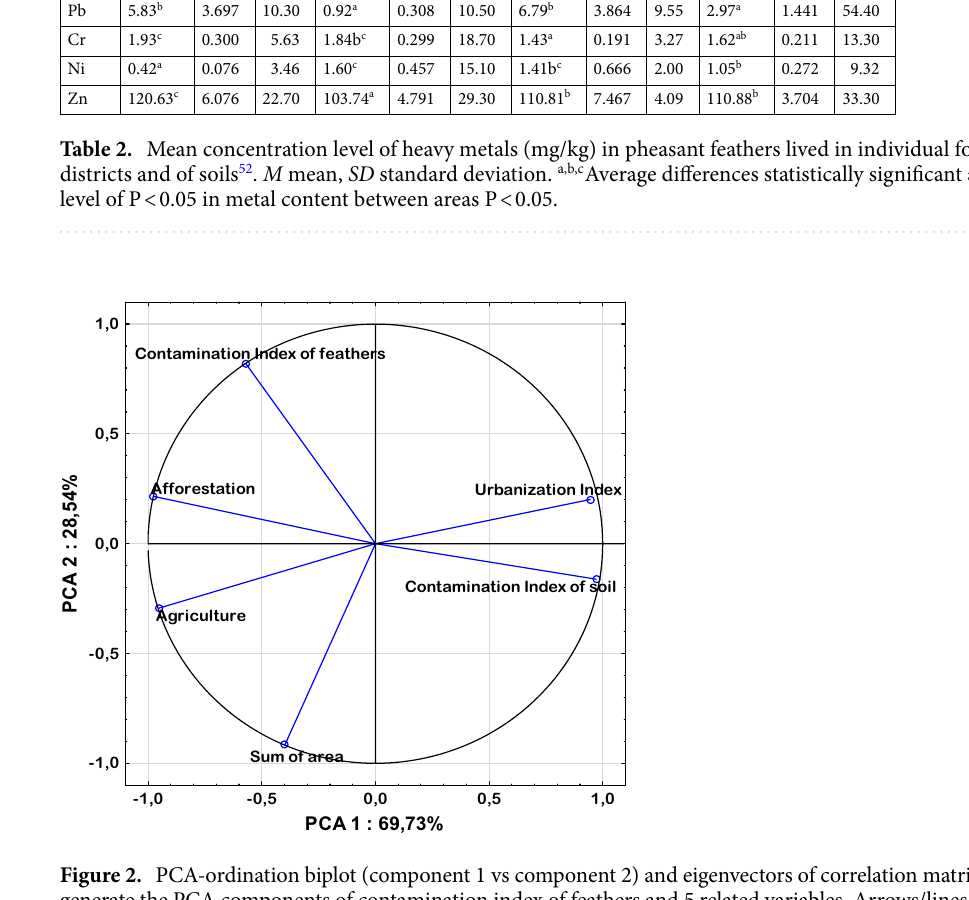
Figure 2. PCA-ordination biplot (component 1 vs component 2) and eigenvectors of correlation matrix used to generate the PCA components of contamination index of feathers and 5 related variables. Arrows/lines in biplot represent variable loadings relative to each component.